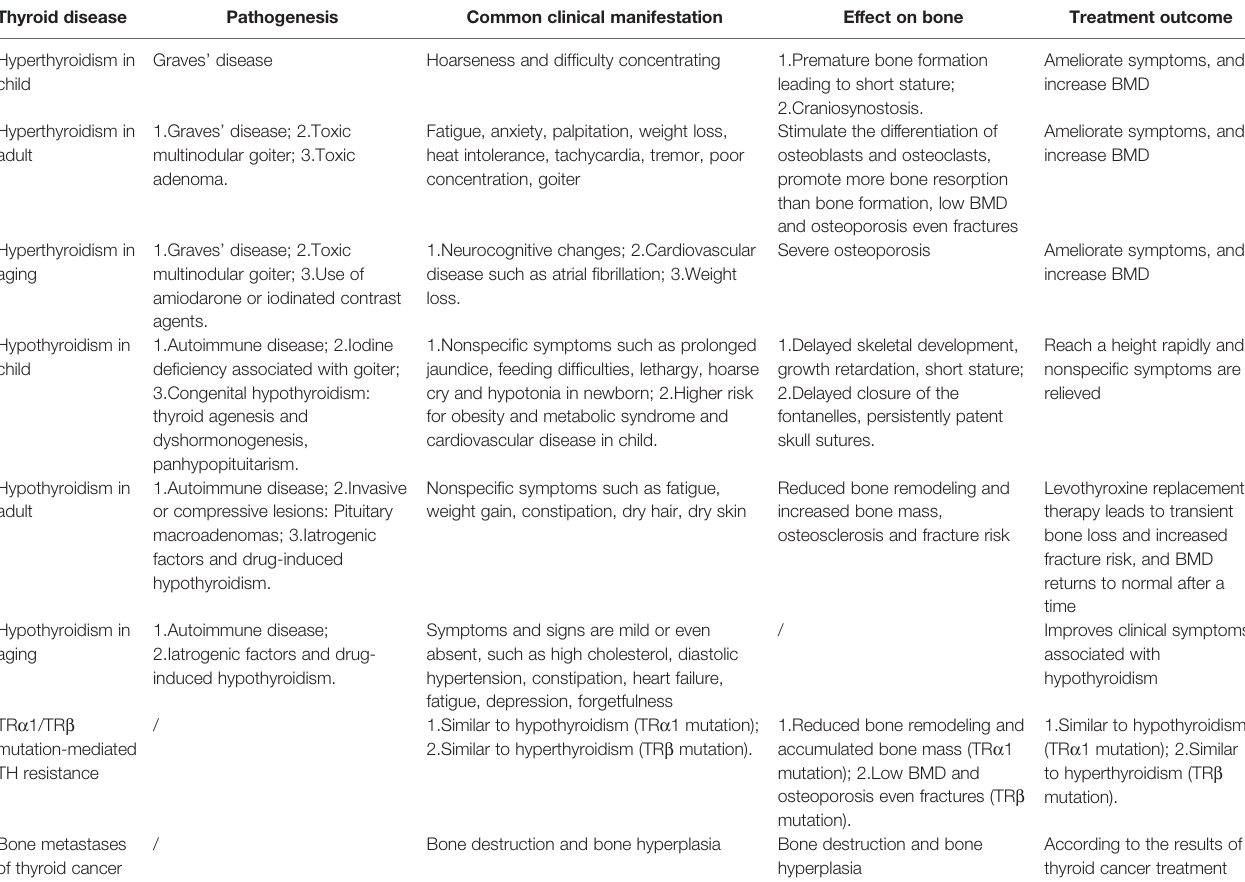
TABLE 2 | Thyroid dysfunction acts on